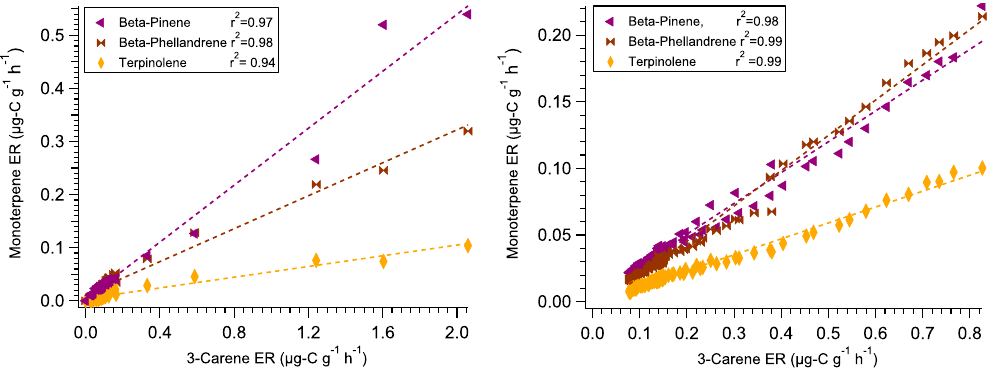
Figure 13. Scatterplots investigating the covariance between major constitutive emissions from Pinus aristata vs. 3-carene (the dominant constitutively emitted compound). Results from the linear regression fits of the data are summarized in the legends. The methyl jasmonate (MeJA) experiment is shown on the left and the negative control experiment is shown on the right.